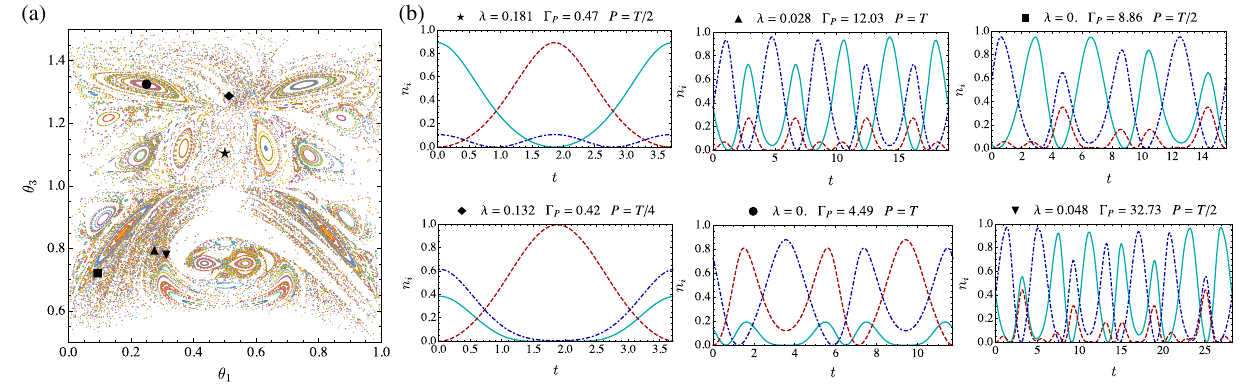
_ θ 0 Þ reveals a 2 <